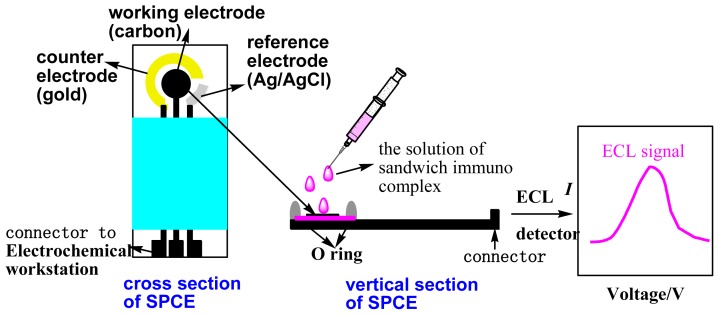
The immunoassay procedure [28].